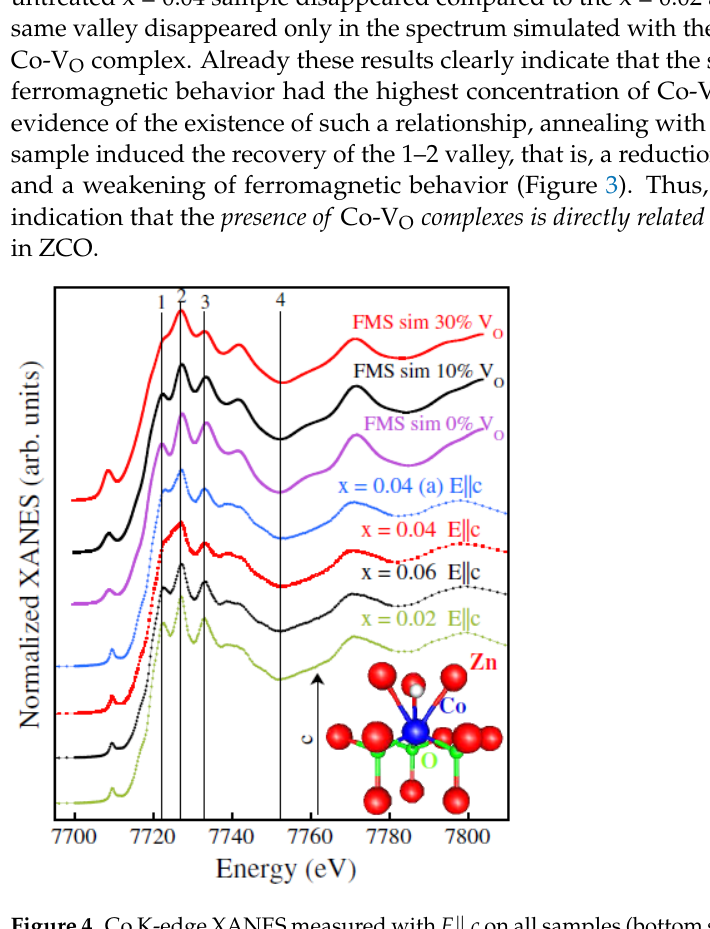
Figure 4. Co K-edge XANES measured with E ‖ c on all samples (bottom spectra) and FMS simulations (top spectra). Inset: Sketch of the Co-V O ‖ c complex used in the simulations. The V O is represented by the white sphere (see also Figure 1b). Reproduced with permission from [73]. Copyright 2001 American Physical Society.